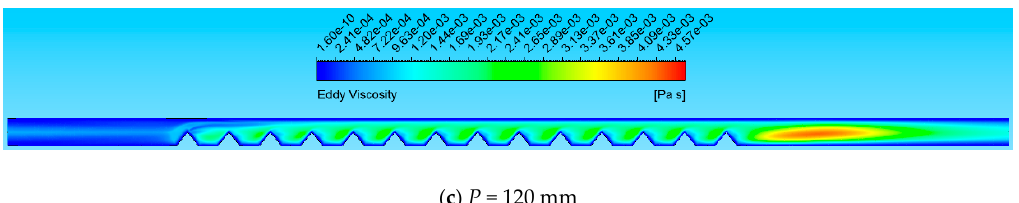
Figure 12. Contours of eddy viscosity at Reynolds number of 12,000, for a fixed value of height ( e = 40 mm) and length ( l = 65 mm), and different value of pitch ( P ).